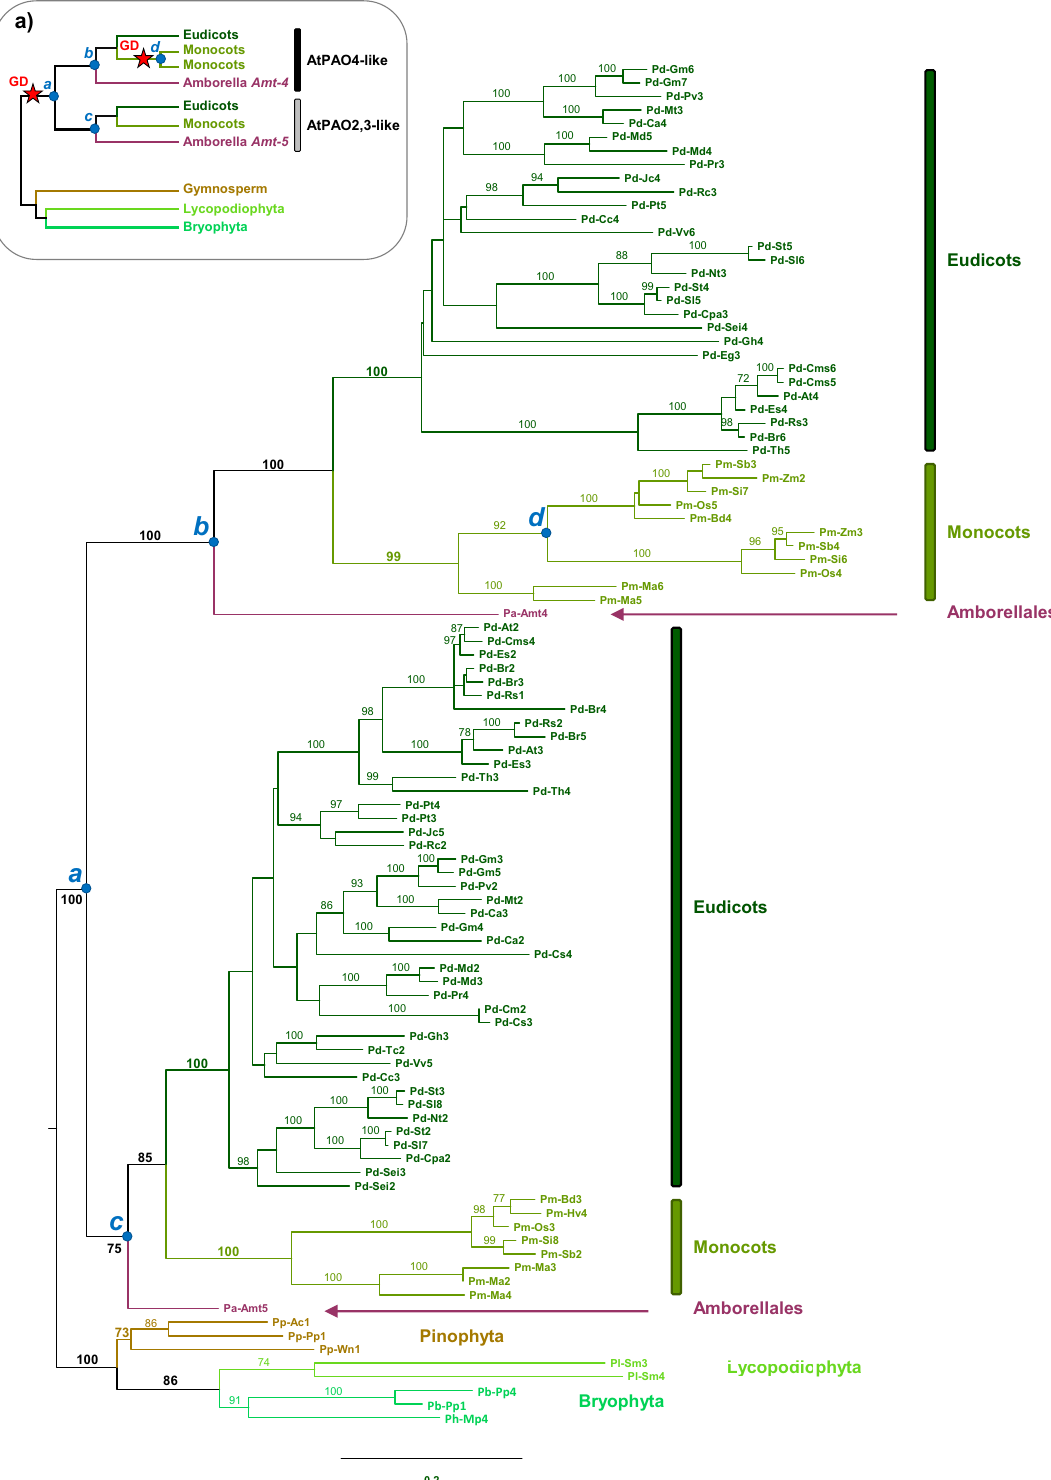
Figure 5. Maximum likelihood phylogeny of plant PAOs of the AtPAO2,3,4-like clade (see Fig. 2) based on 100 amino acidic sequences. Main clades are labelled from a to c ; bootstrap values of support (BS) are reported along the branches (BS > 70). Box ( a ) illustrates the evolutionary model for the AtPAO2,3,4-like proteins with two gene duplications (GD) in correspondence of node a (giving rise to the AtPAO2,3 and AtAPO4 subclades) and d